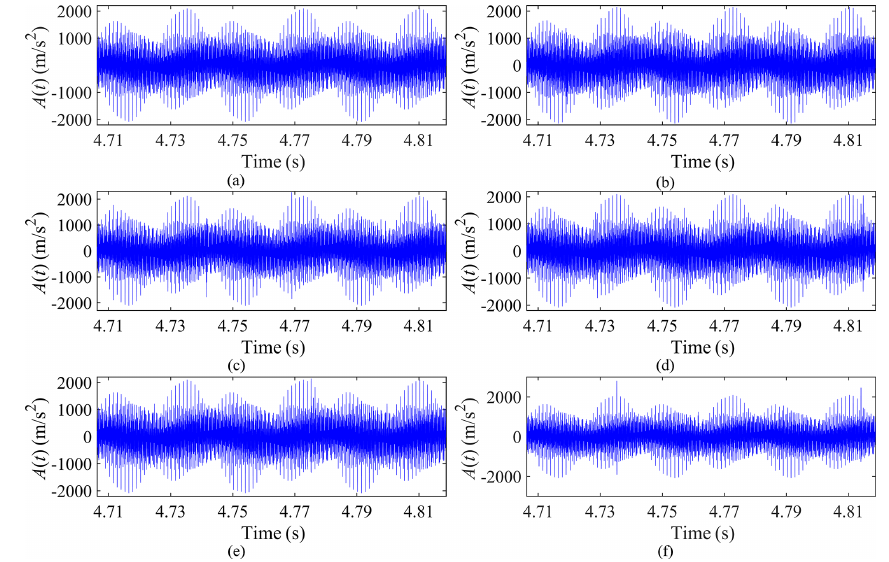
Figure 7. Synthetic vibration signals in the vertical direction: (a) healthy gear case, (b) failure case I, (c) failure case II, (d) failure case III, (e) failure case IV, and (f) failure case